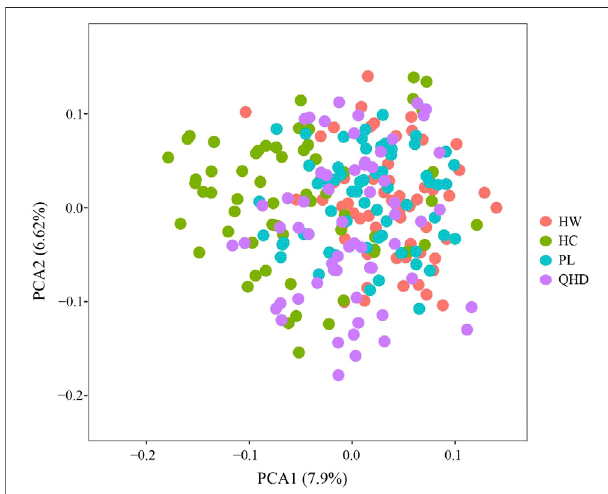
FIGURE 5 | PCA analyses based on SSR data for 240 individuals from 4 P. trituberculatus populations.